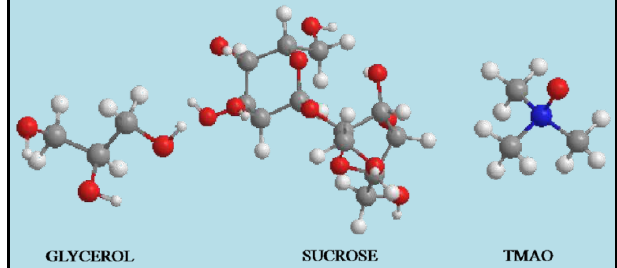
Figure 1. Energy minimized structure of osmolytes used in study. Brown, white, red and blue color balls represent carbon, hydrogen, oxygen, and nitrogen atoms,